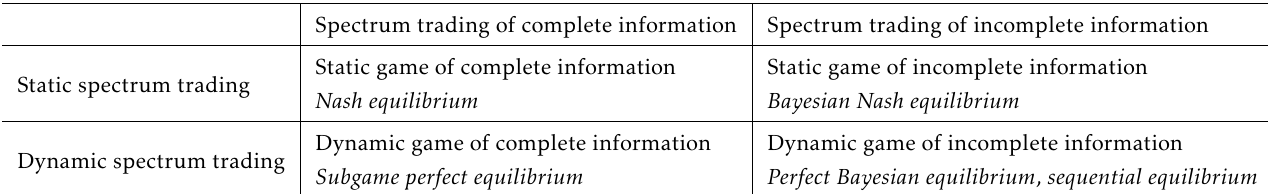
Table. 3. Game modeling and equilibria for non-cooperative spectrum